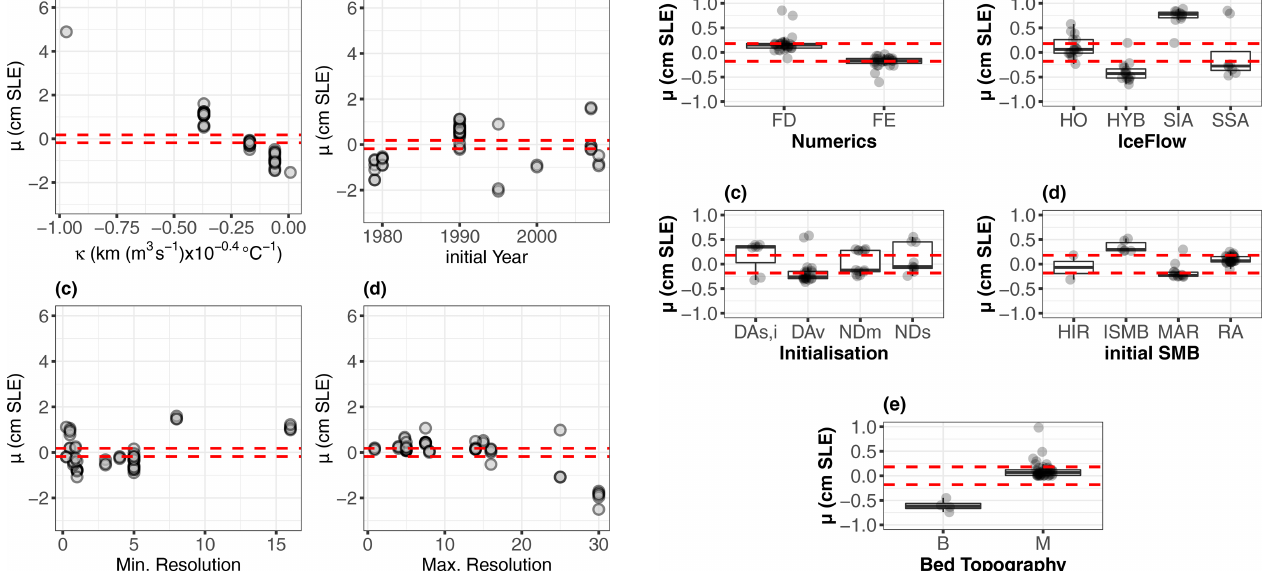
Figure 8. Application of SHAP to all members of the MIROC5 RCP8.5-forced GrIS MME for the year 2100. Each panel provides the boxplots of µ values given the modelling choice for the nu- merical method (a) , the ice flow (b) , the initialisation (c) , the ini- tial SMB (d) , and the type of bed topography dataset (e) . Each dot corresponds to a given MME member. The horizontal dashed red lines indicate the limits defined by ± MAE calculated from the cross-validation